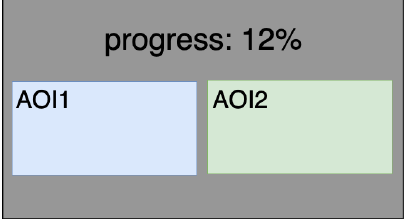
Figure 4. The AOIs defined to filter the ET signal for displayed